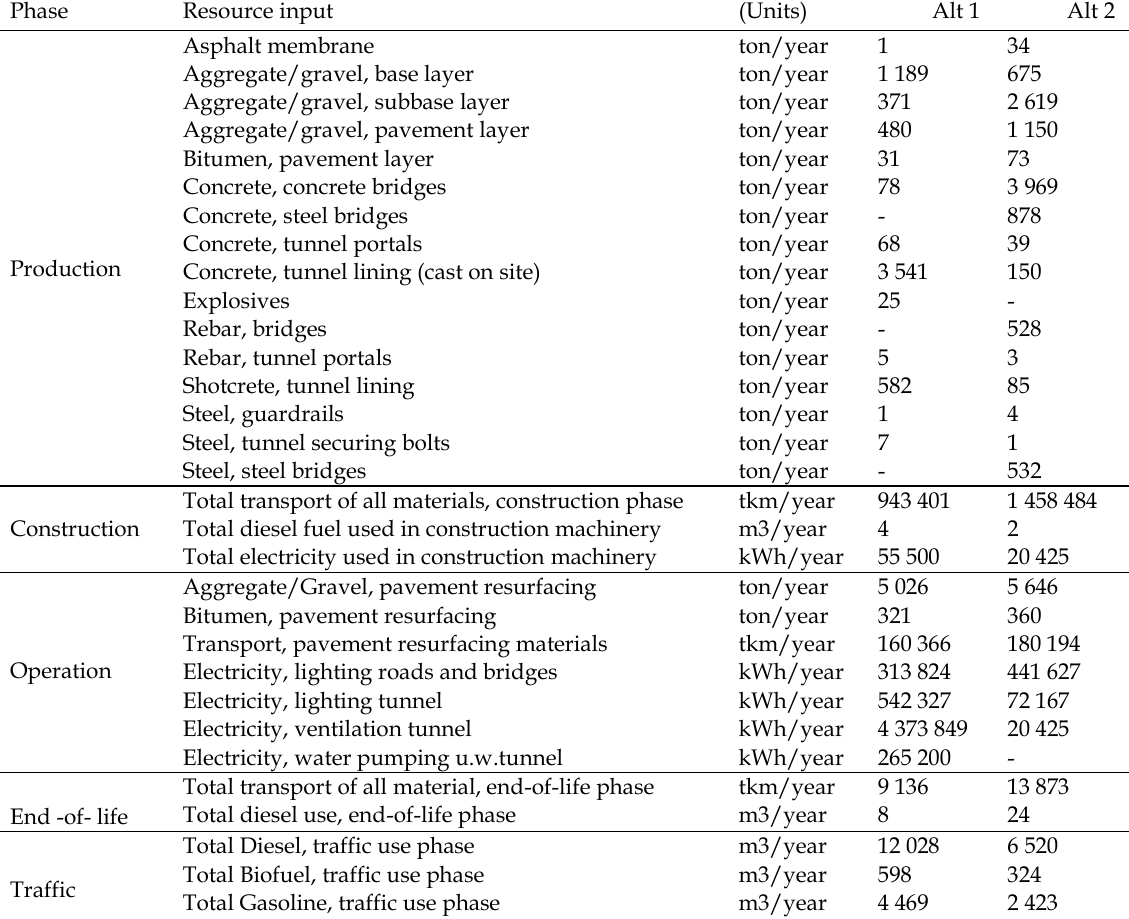
Table 3. Life cycle inventories of Oslo fjord crossing alternatives 1 and 2